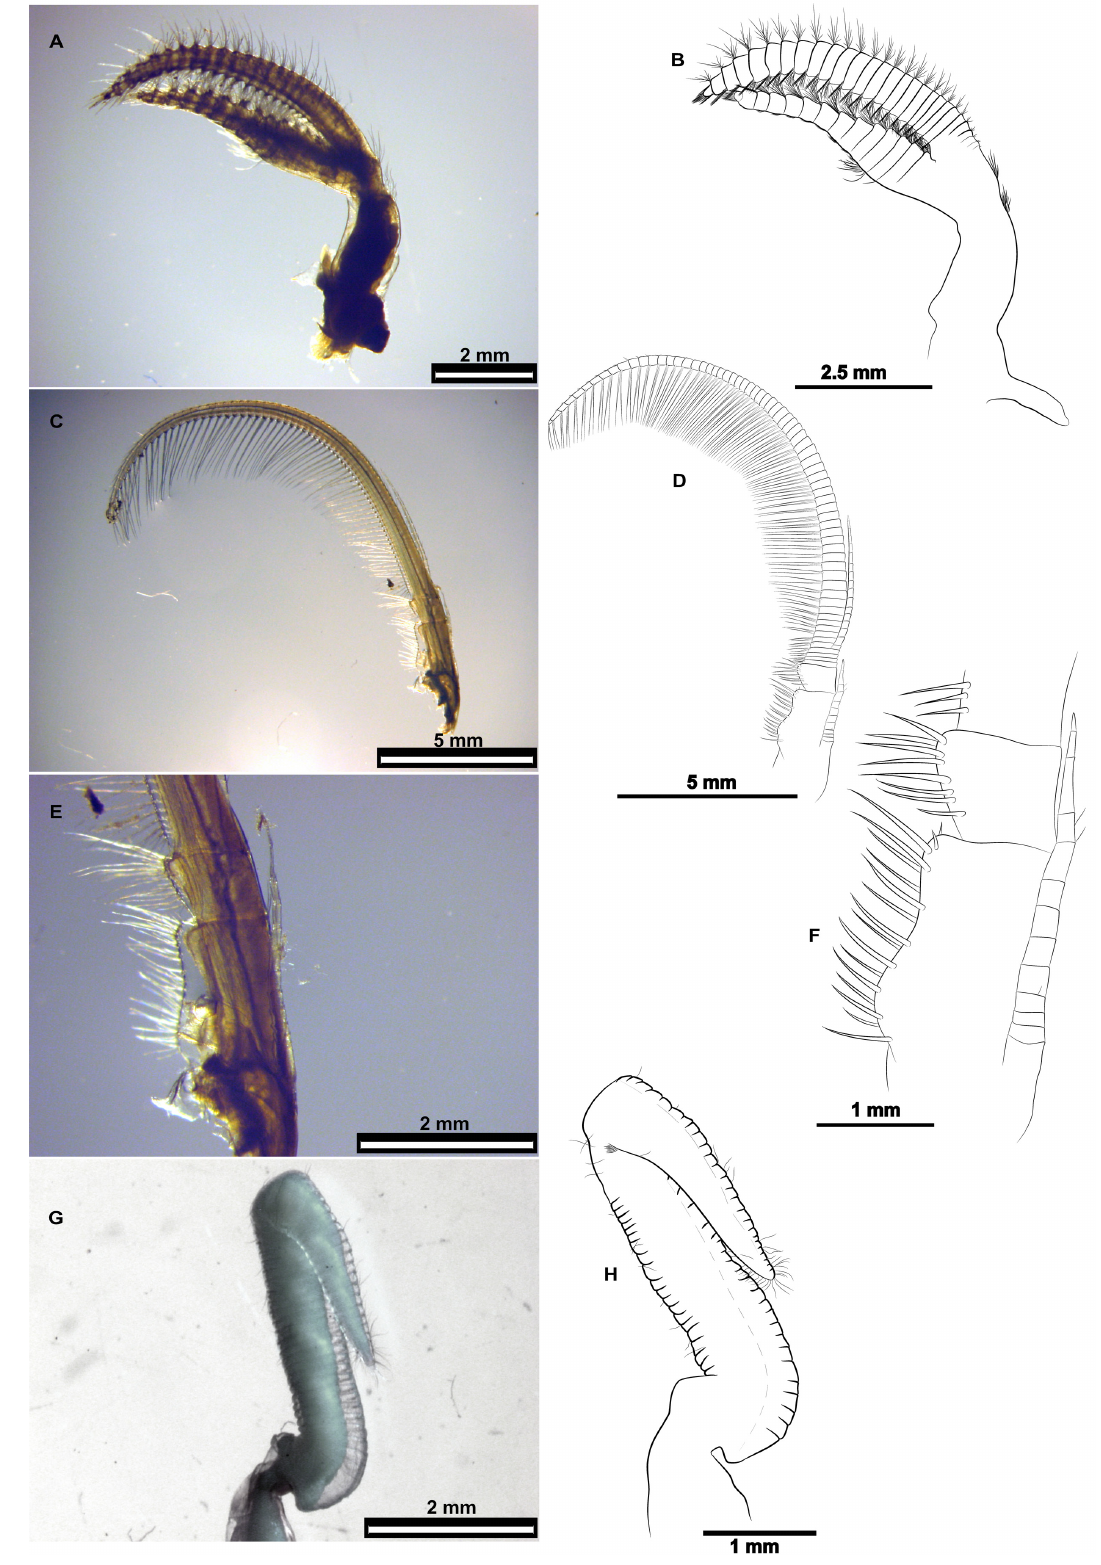
Fig. 5. Line drawings and pictures of Heteralepas gettysburgensis sp. nov. (holotype) A–B . Cirrus I. C–D . Cirrus VI. E–F . Caudal appendage. G–H .